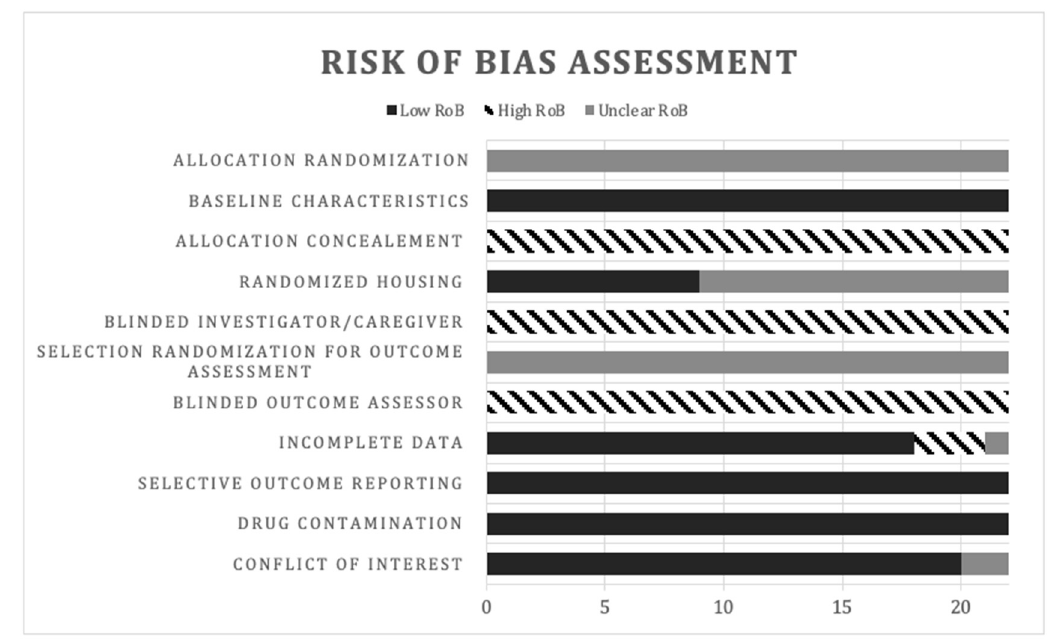
Figure 4. Evaluation of bias; risk of bias (RoB).